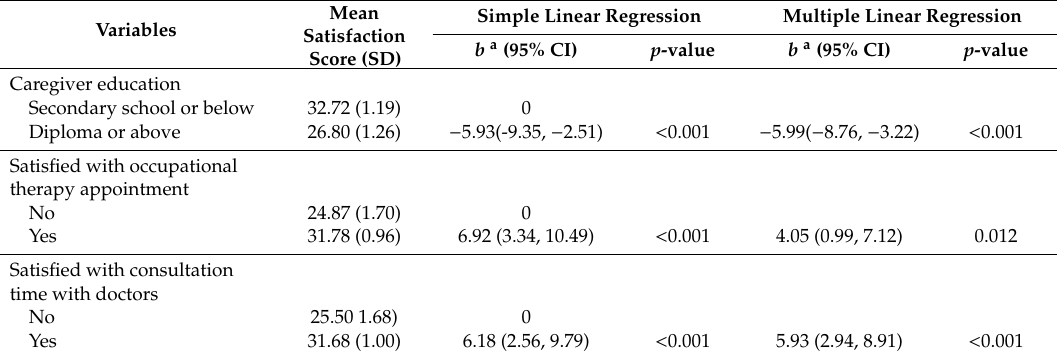
Table 5. Predictors of caregivers’ satisfaction with the health care management of children with ASD at secondary care in Kelantan ( n =